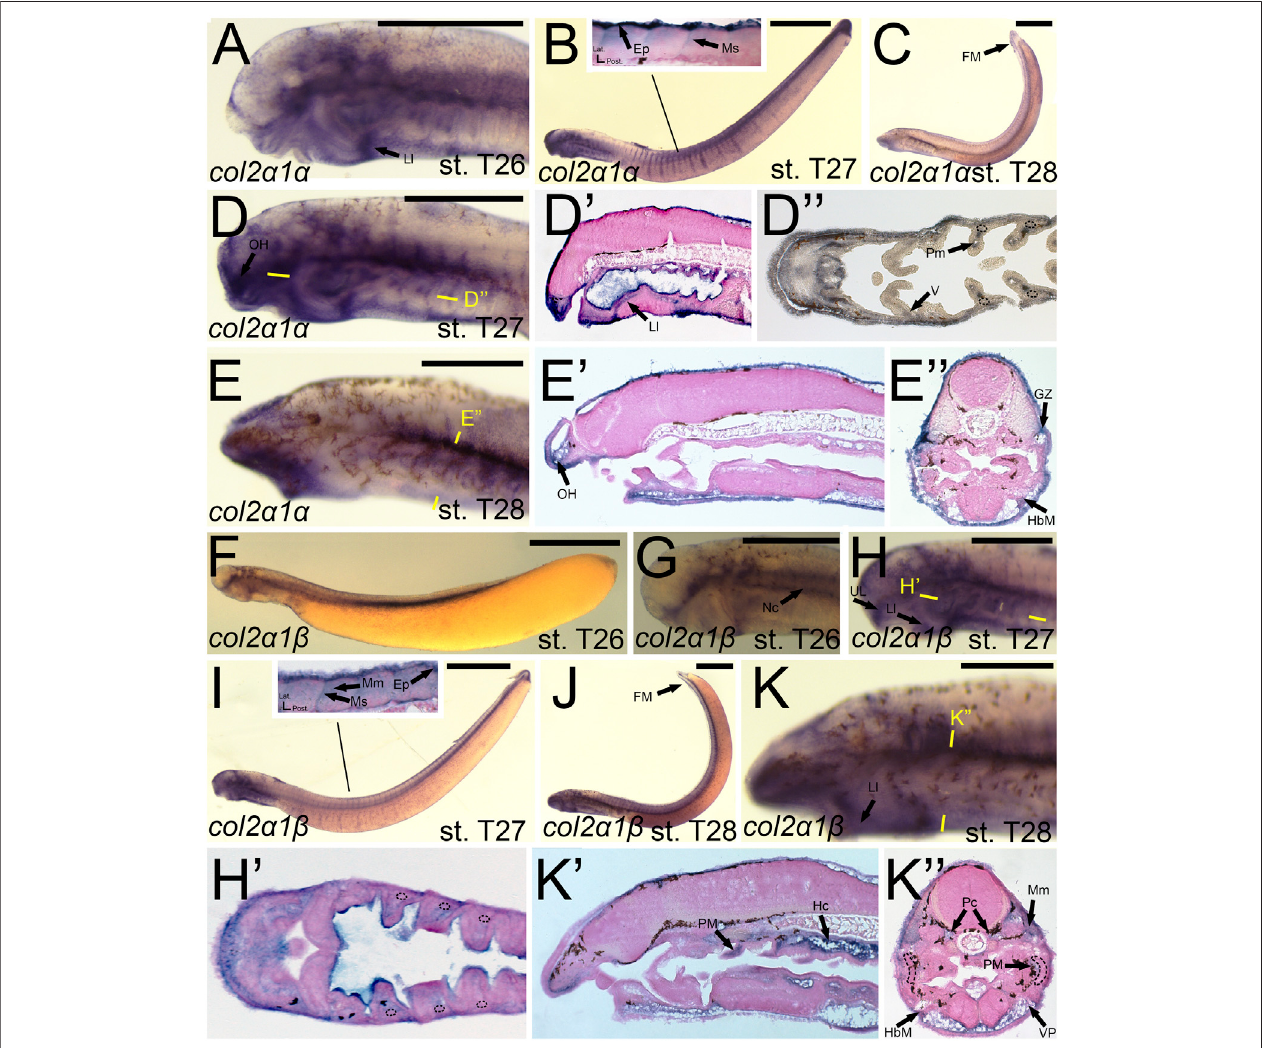
FIGURE 6 | Expression of colA3 / col2a1 α and colA5/col2a1 β in larval lamprey. All scale bars are approximately 500 μ m. (A) col2a1 α expression was in the facial ectoderm and the mesenchyme of the lower lip. (B,D) col2a1 α expression was additionally found in the mesenchyme of the oral hood and lower lip as well as the lateral velum, pharyngeal muscle, epidermis, and myosepa. Dotted circles indicate presumptive branchial arch skeleton. (C,E) col2a1 α expression was in the mesenchyme of the fi nfoldandoralhood,andwasalsointhehypobranchialmusculatureandgrowthzone. (F,G) col2a1 β expressionwasinthenotochord,cranialganglia,andthe mesenchyme ofthe upper and lower lip. (H,I) col2a1 β expression was inthe mesenchyme ofthe upper and lower lip, the pharyngeal muscle, the myomeres, epidermis, andthemyosepta. (J,K) col2a1 β expressionwasinthemesenchymeofthe fi nfold,ventralpharynx,andlowerlip,thepharyngealmuscle,themyomeres,hypobranchial musculature, posterior hypochord, as well as the cartilages of the parachordals. Dotted circles indicate presumptive branchial arch skeleton. Keywords: Ep: epidermis; FM: fi nmesenchyme; HbM: hypobranchialmusculature; GZ: growth zone; Hc:hypochord; LL:lower lip;Mm: myomeres; Ms: myosepta; Nc:notochord; OH:oral hood; Pc: parachordals; PM: pharyngeal muscule; UL: upper lip; V: velum; VP: ventral pharynx.